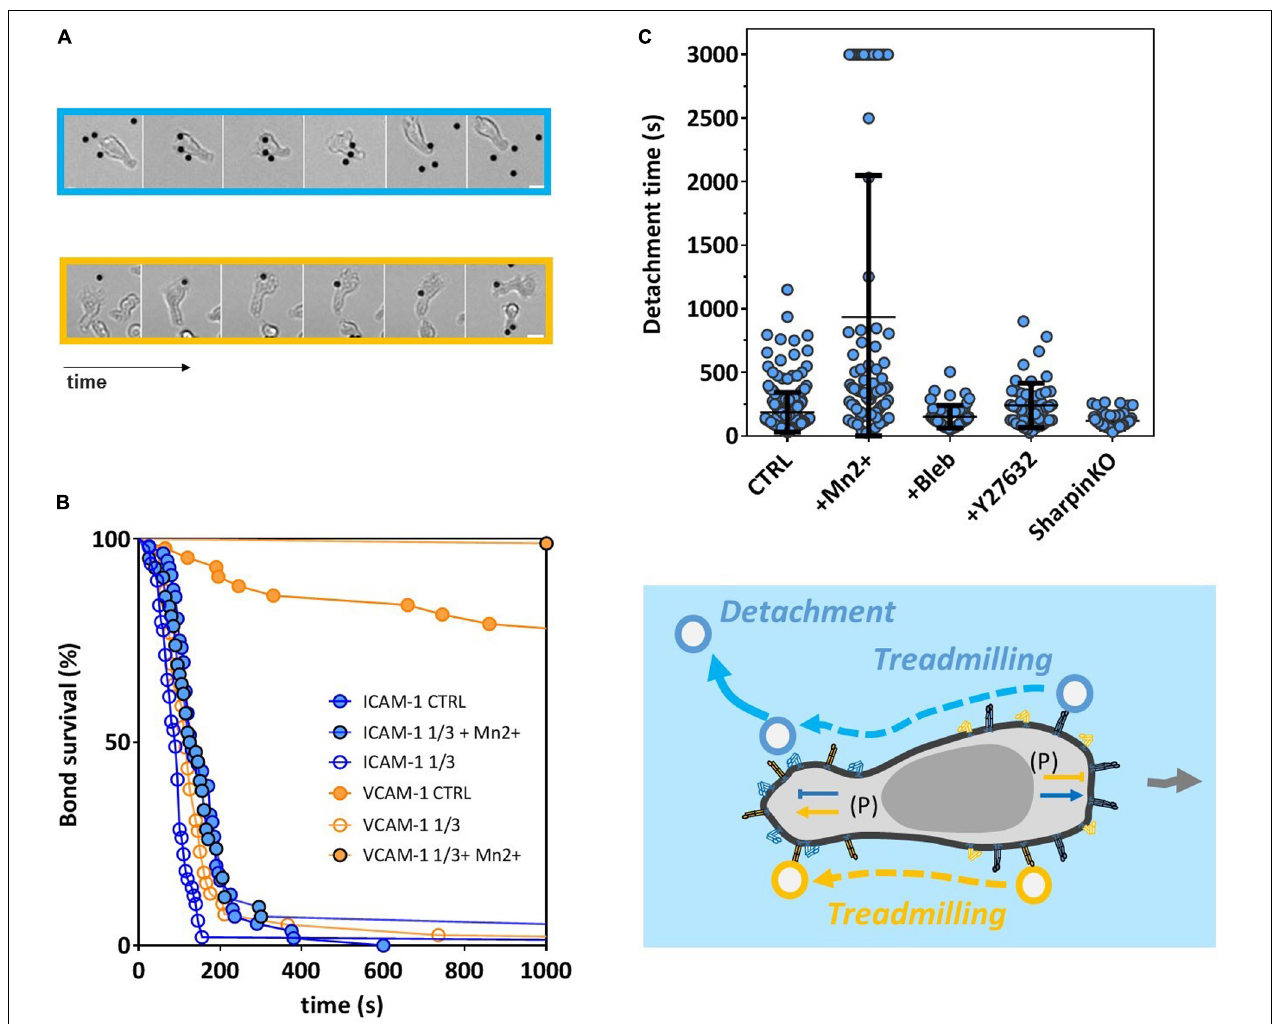
FIGURE 4 | Polarization signals controlling integrin affinity are active independently of cell adhesion to a solid substrate. (A) Image sequence showing beads coated with ICAM-1 (top) or VCAM-1 (bottom) that attached to a cell front, treadmilled backward on cell body, and either detached spontaneously on cell rear for ICAM-1 beads or remained attached for VCAM-1 beads. From left to right, time is 15, 66, 78, 114, and 222 s for ICAM-1 and 300 s, and 0, 105, 135, 153, 177, and 333 s for VCAM-1. Scale bar is 5 µ m (see also Supplementary Movie 2 ). (B) Bead/cell survival bonds for cells swimming without adhesion over a substrate passivated by Pluronics F127 and beads coated with either ICAM-1 (blue line) or VCAM-1 (orange line), with CAM densities of 2400 molecules/ µ m − 2 for CTRL, 800 molecules/ µ m − 2 for ICAM-1 and VCAM-1 1/3, and with or without Mn 2 + at 3 mM (black contour dots). Number of independent experiment Ne = 3. Number of events per experiment > 50. (C) Bead/cell detachment times for wild cell beads coated with ICAM-1 at 2400 molecules/ µ m − 2 in normal medium (CTRL) and with Mn 2 + at 3 mM, blebbistatin at 50 mM, and Y27632 40 µ M, and for Sharpin-deficient cells in normal medium. Independent experiment Nexp = 2. Events per experiment Ne > 50. (D) Cartoon of a swimming cell and beads coated with ICAM-1 (blue) or VCAM-1 (orange). Arrows outside cell indicate cell displacement. Arrows and T bars inside cell indicate, respectively, activating and inhibiting effects on LFA-1 (blue) and VLA-4 (orange). (P) indicates that signal comes from polarization